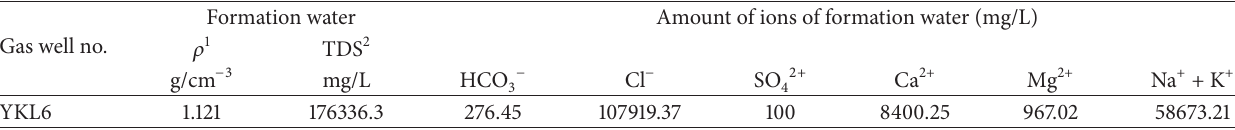
Table 2: Properties of formation water.